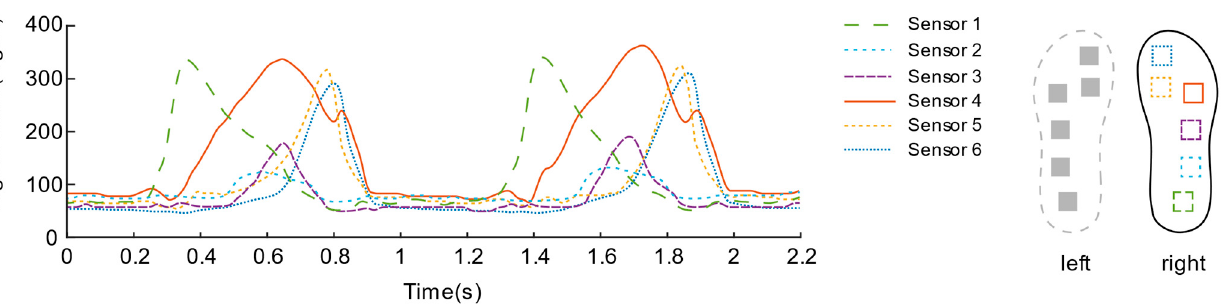
Figure 14. The experimental setup. ( a ) equipment used ( b ) sensing system setup back view ( c ) sensing system setup front view.